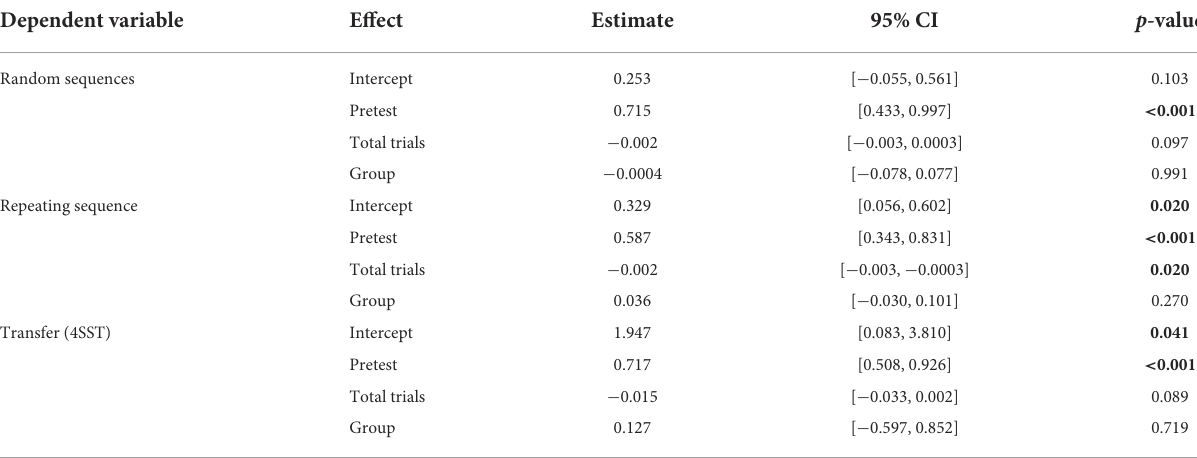
TABLE 3 Relationship of group assignment and number of trials completed to learning of the Serial Reaction Time Task (SRTT) and transfer effects on the Four Square Step Test